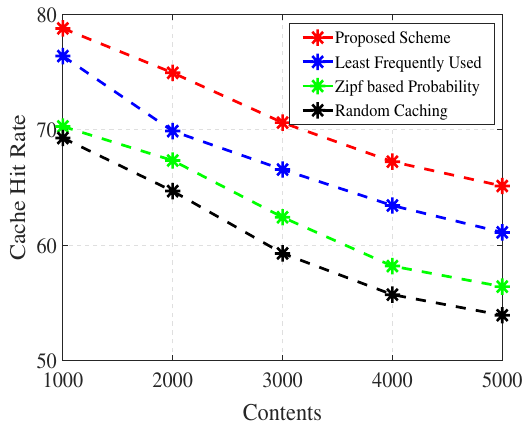
Figure 6. Cache hit rate versus contents with U = 50, H = 50 MB, and Q = 1